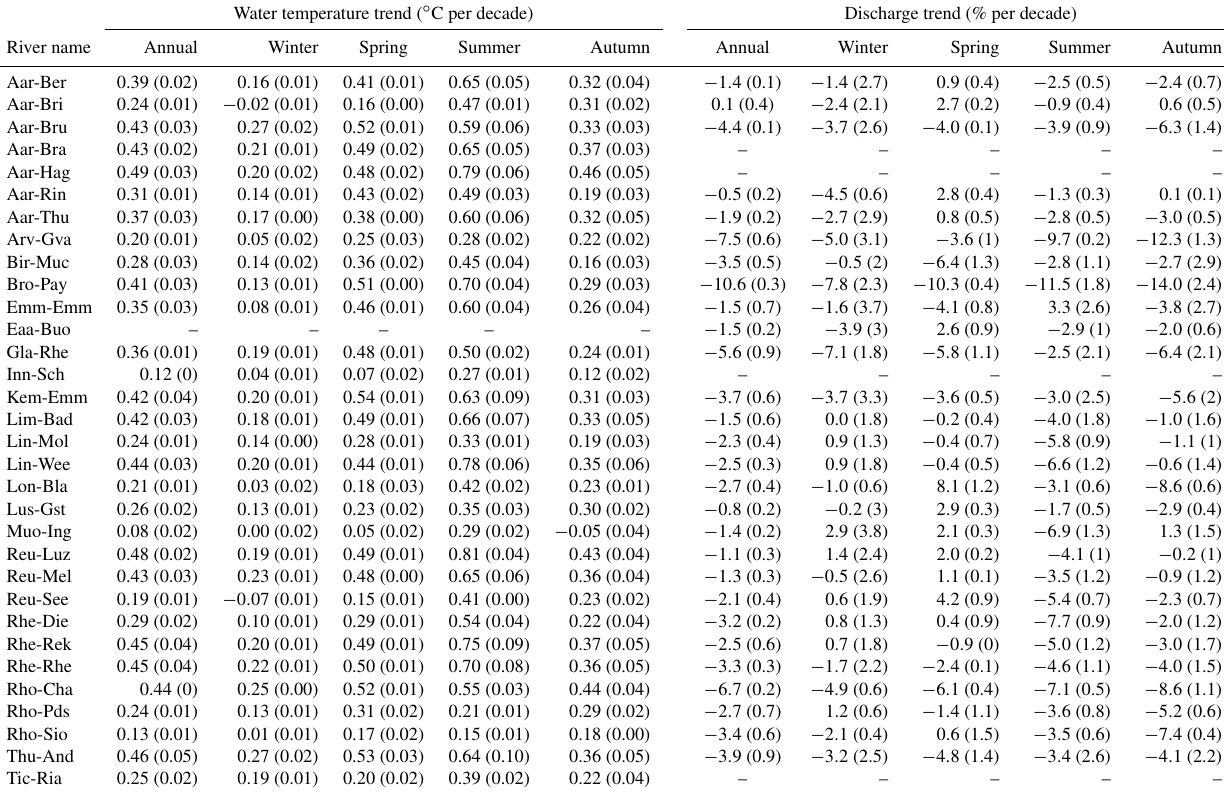
Table A2. Water temperature (left section) and discharge (right section) annual and seasonal trends for all catchments presented in Table 1 over the 1979–2018 period. The numbers in parentheses indicate the standard error of the computed trends based on linear